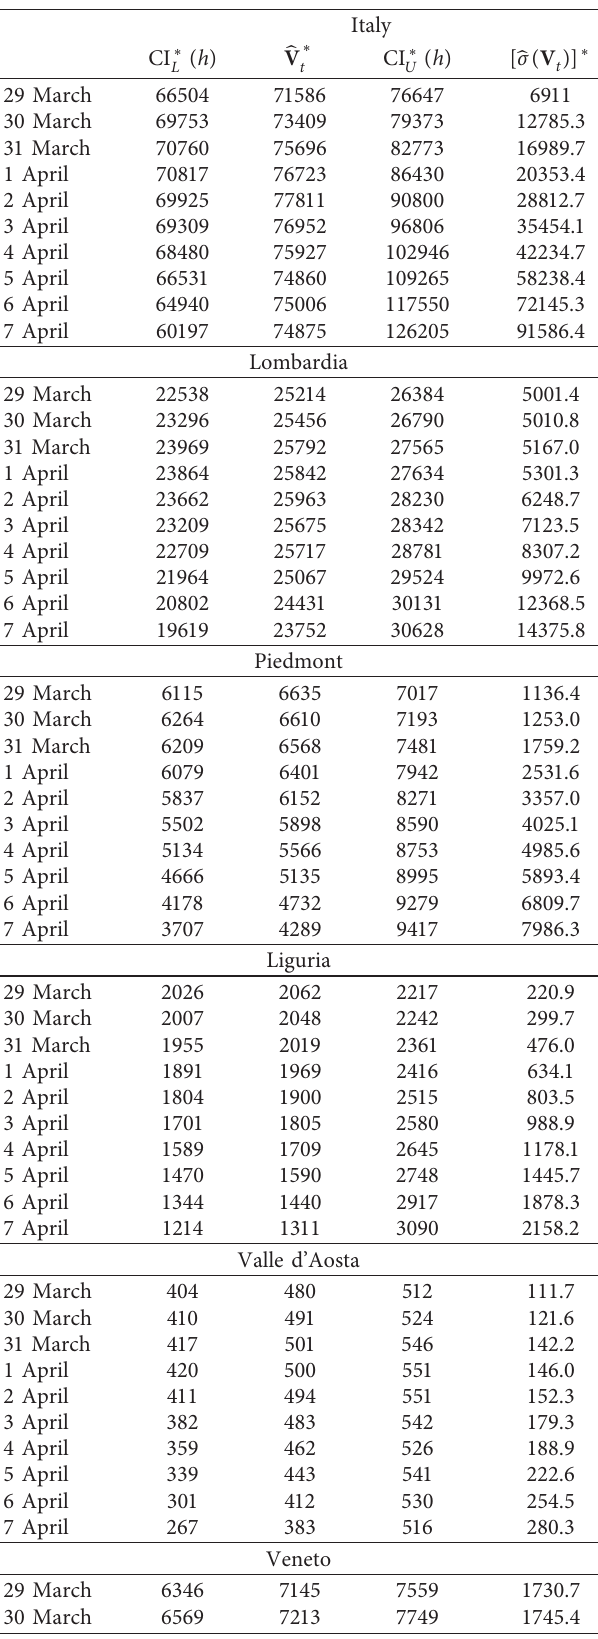
Table 1: 10-step-ahead predictions for the variable V persons tested